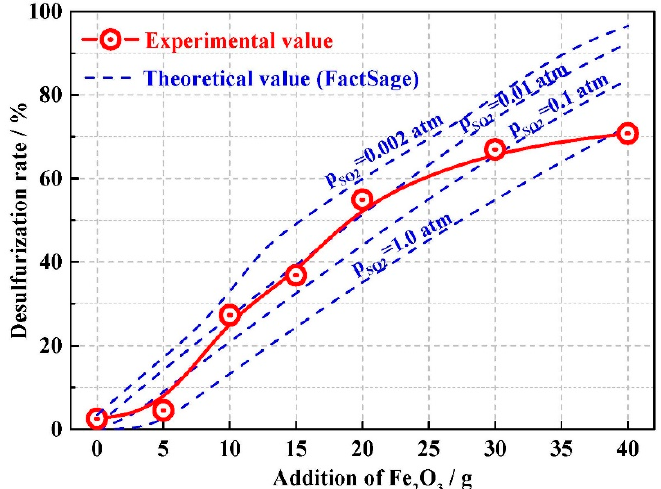
Figure 4. E ff ect of Fe 2 O 3 addition on desulfurization Figure 4. Effect of Fe 2 O 3 addition on desulfurization rate.